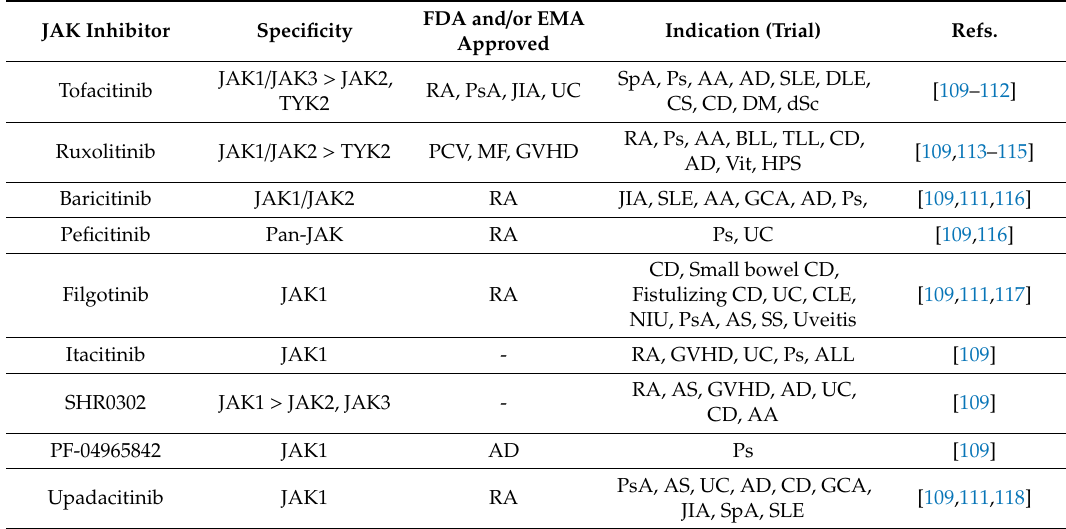
Table 2. JAK inhibitors for the management of immune-mediated diseases. JAK Inhibitor